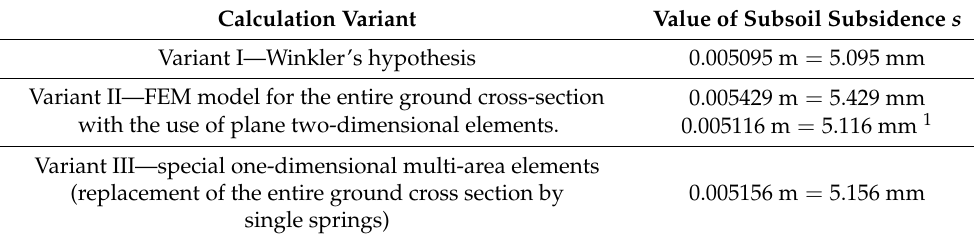
Table 2. Comparison of the subsoil subsidence values [mm], Figure 8 Calculation Variant Value of Subsoil Subsidence s Variant I—Winkler’s hypothesis